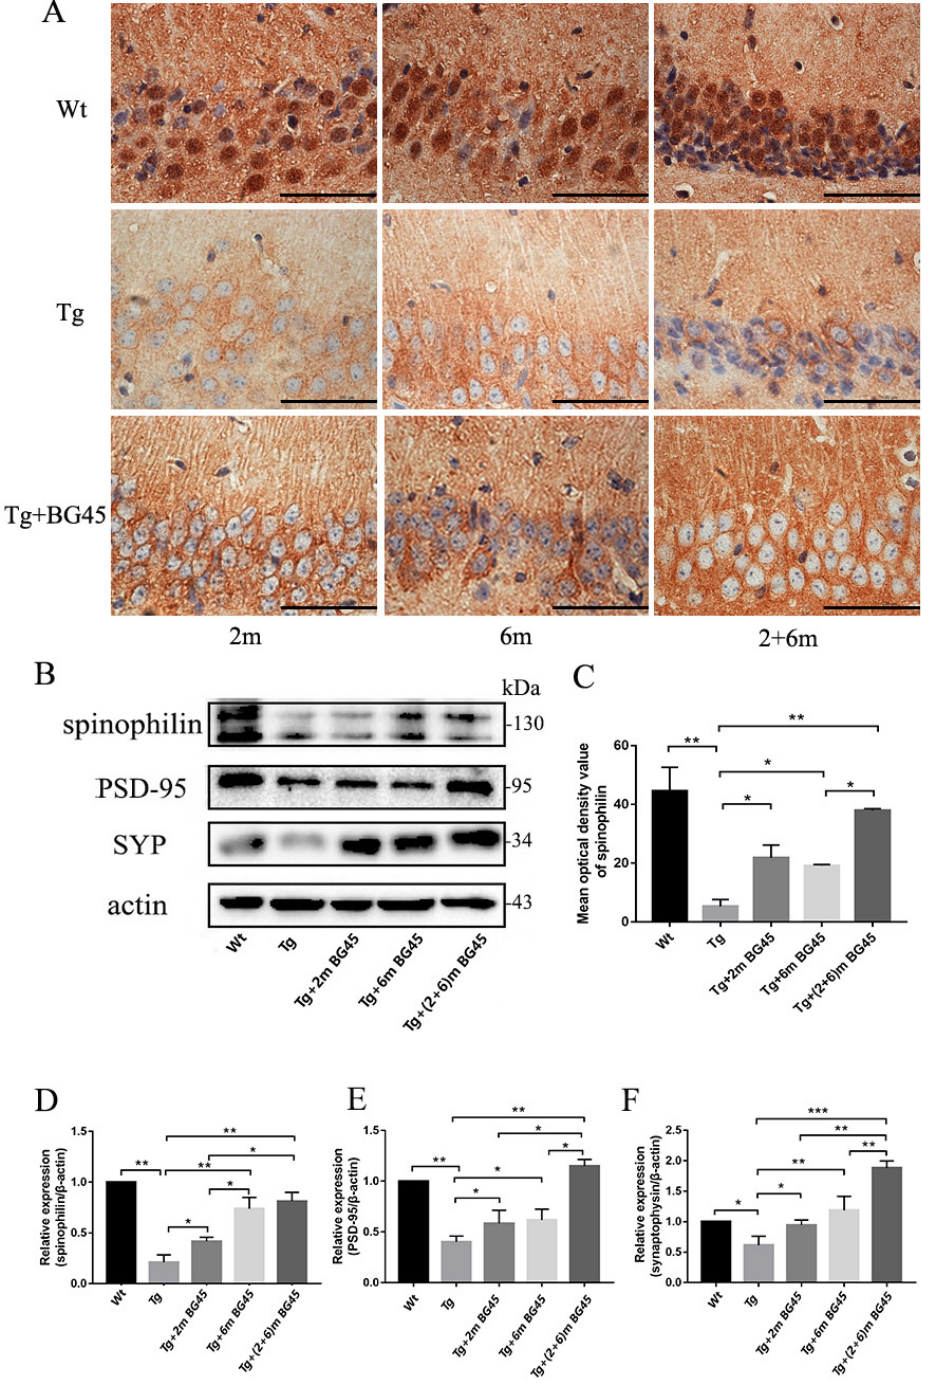
Figure 10. BG45 upregulates the expression of synapse-related proteins in hippocampal neurons of APP/PS1 mice ( n = 5). ( A ) Immunohistochemical staining for the spinophilin protein in hippocampal neurons from mice treated with vehicle or BG45. ( B ) Immunoblot analyses showing levels of the spinophilin, PSD-95, and synaptophysin proteins in the hippocampus of mice treated with vehicle or BG45. ( C ) Quantification of spinophilin levels in the hippocampus. ( D – F ) Quantification of levels of synapse-related proteins. Scale bar = 100 µ m ( A ). Significant differences were determined using one-way ANOVA. All values are presented as the means ± SD from three independent experiments. * p < 0.05, ** p < 0.01, and *** p < 0.001, n = 5 mice per